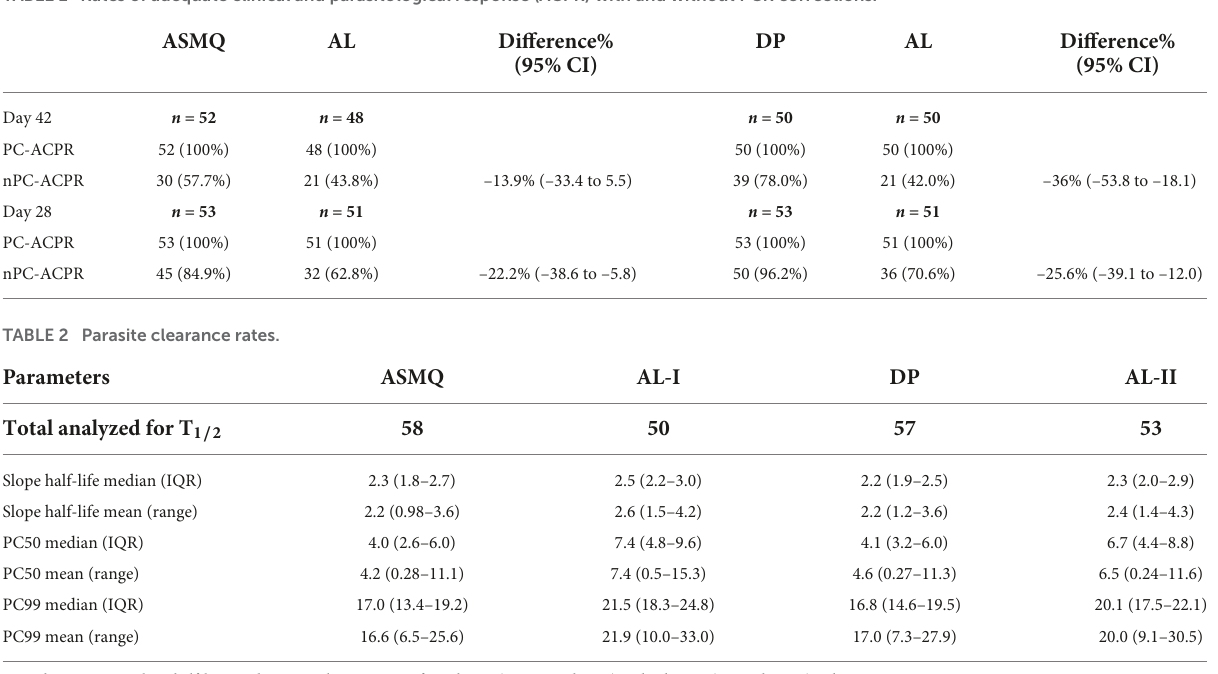
TABLE 1 Rates of adequate clinical and parasitological response (ACPR) with and without PCR corrections.